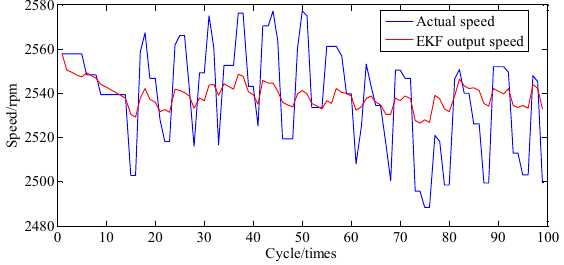
Figure 14. Speed tracking at A/F ratio 0.95.